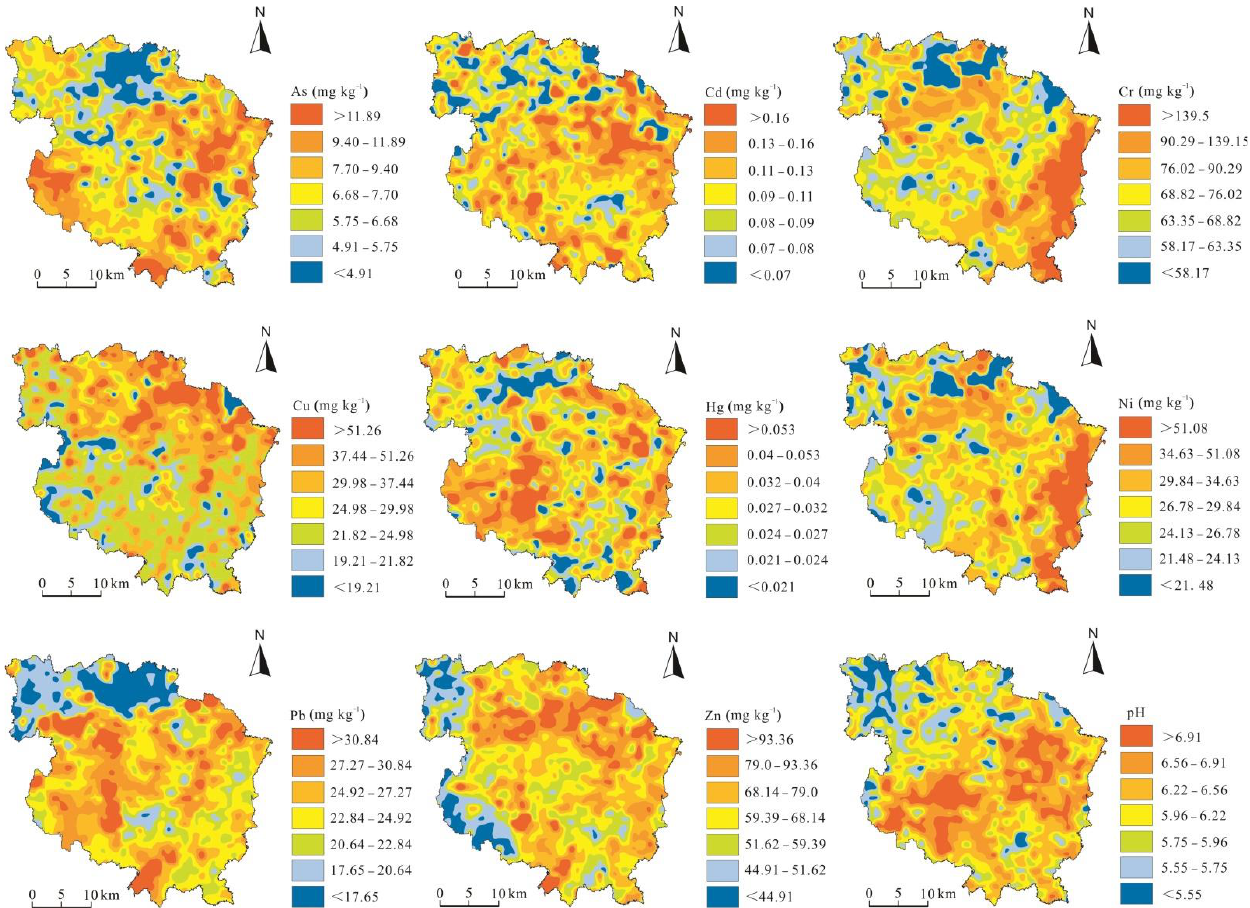
Figure 5. Spatial distributions of pH and eight heavy metals in soils of the study area.